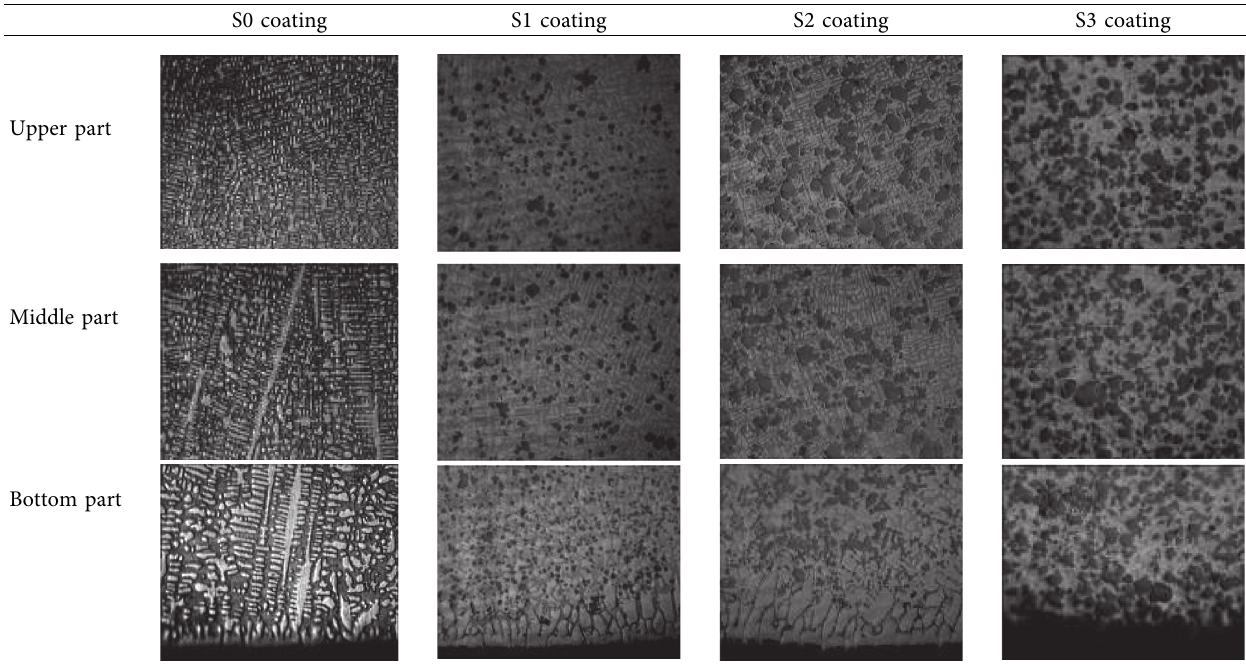
Figure 5: Effect of the load on the friction coefficient at the speed of 200r/min: (a) friction coefficient of S0 coating and H13 steel; (b) the average friction coefficient. Table 4: Microstructure with different shapes of